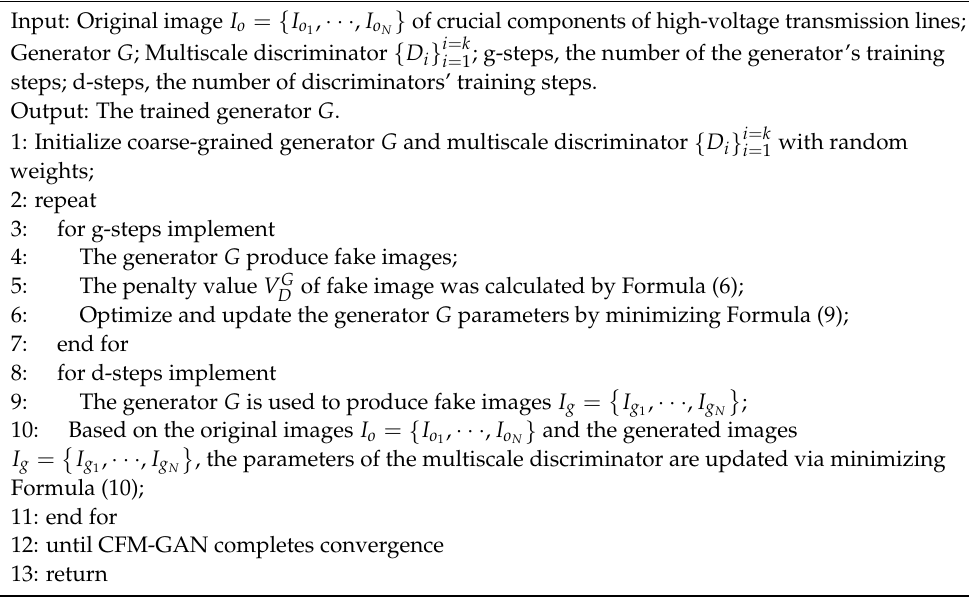
Algorithm 1. The training procedure of